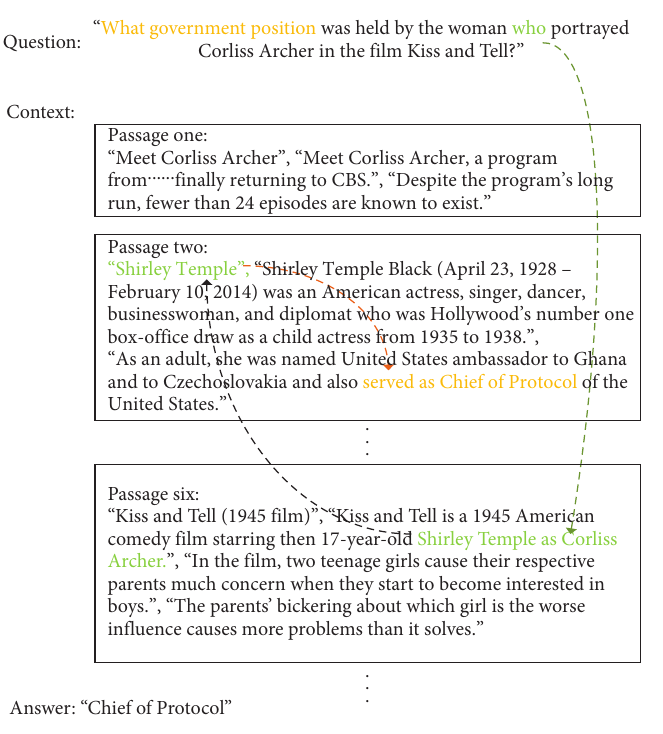
Figure 1: Example of multihop datasets